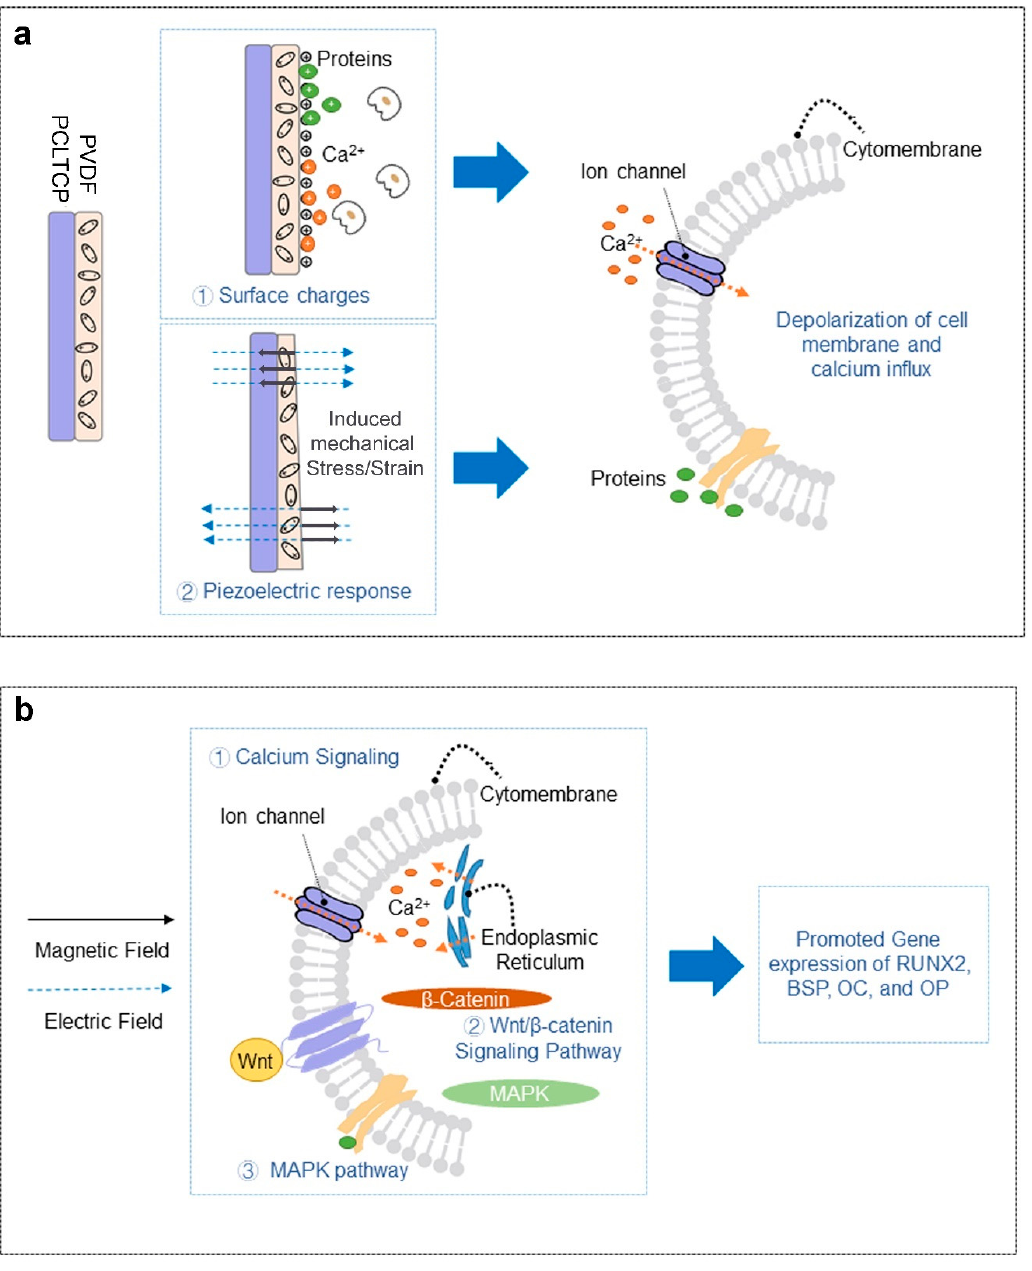
Figure 7. Schematic of the effects of ( a ) PVDF-coated PCL-TCP and ( b ) PEMF on cells. In our study, we observed that PEMF exposure exerted a synergistic effect when cells seeded on piezoelectric scaffolds were treated. Over the past decades, the impact of PEMF alone on osteogenesis has been studied for different cell types with a wide range of pa- rameters, with both suppressive and enhancement effects reported. Jansen et al. per- formed PEMF (15 Hz) exposure on human bone marrow-derived stromal cells and found PEMF could enhance mineralization at the expense of proliferation [47]. In contrast, when Ferroni et al. applied PEMF using a miniaturized electromagnetic device on mesenchymal stem cells, they found that both proliferation and differentiation were promoted [48]. Our study was conducted on the murine pre-osteoblastic cell line, MC3T3-E1, using 50 Hz